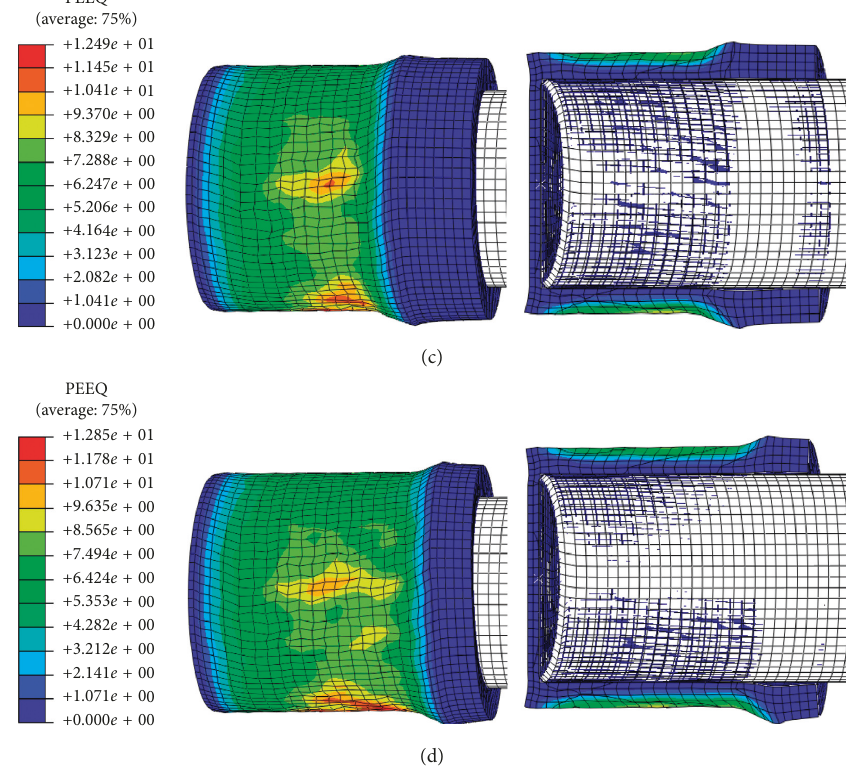
Figure 8: First-pass equivalent strain distribution. (a) 25%. (b) 50%. (c) 75%. (d)